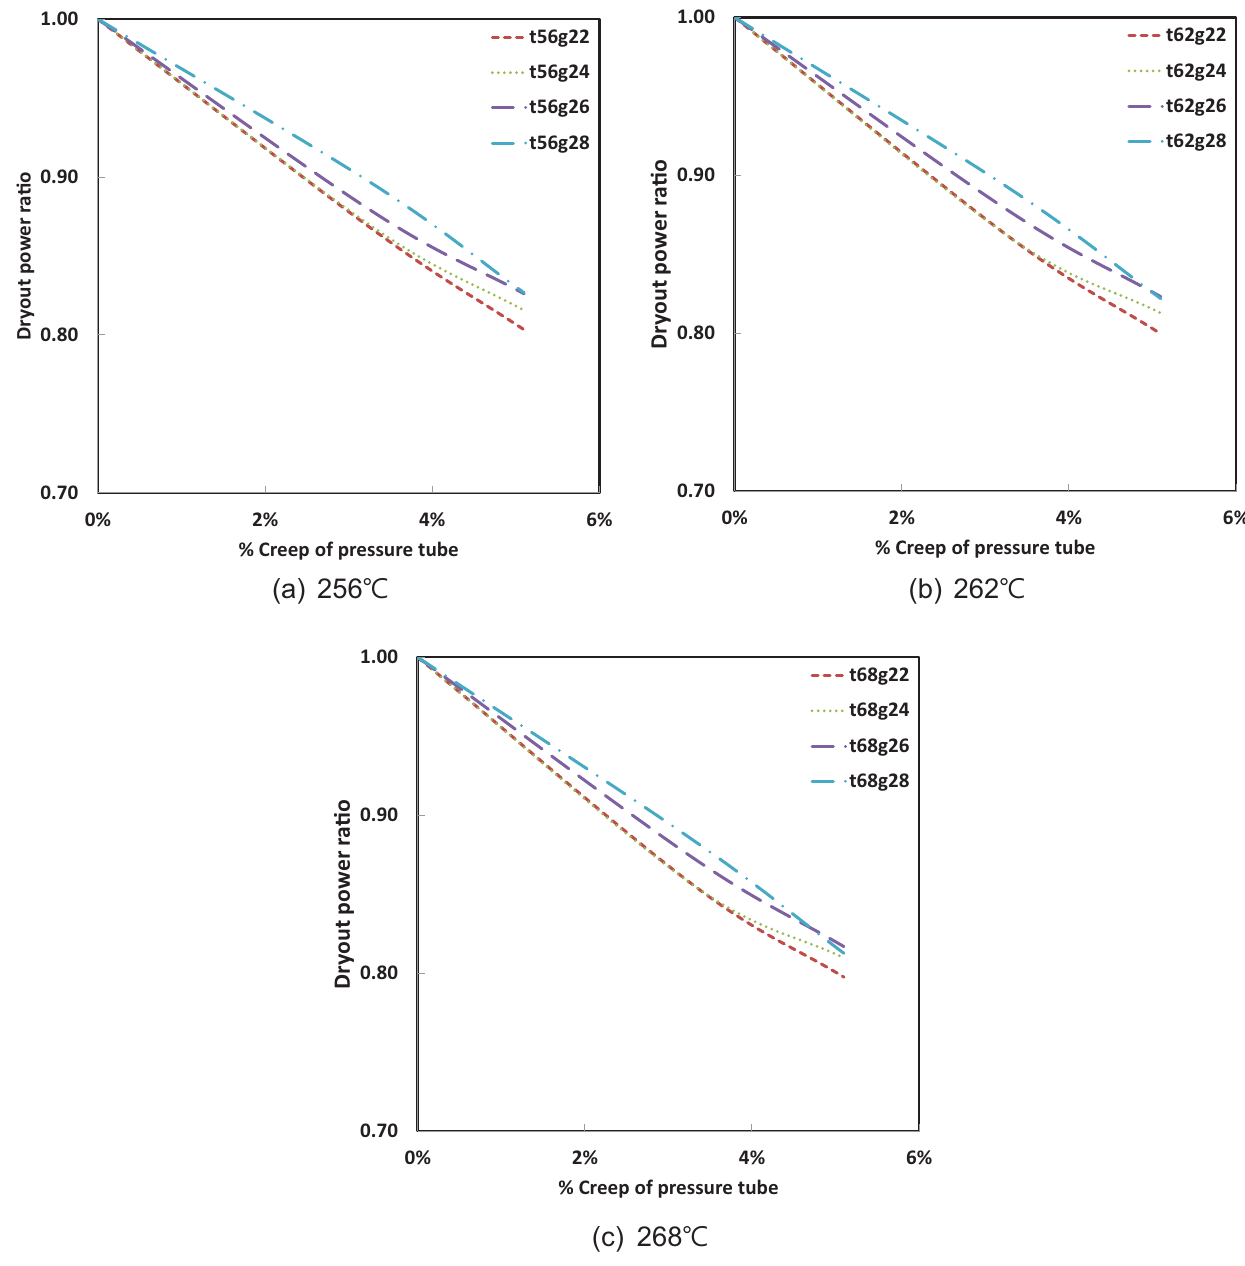
Fig. 5. Dryout power ratios for a 37S fuel